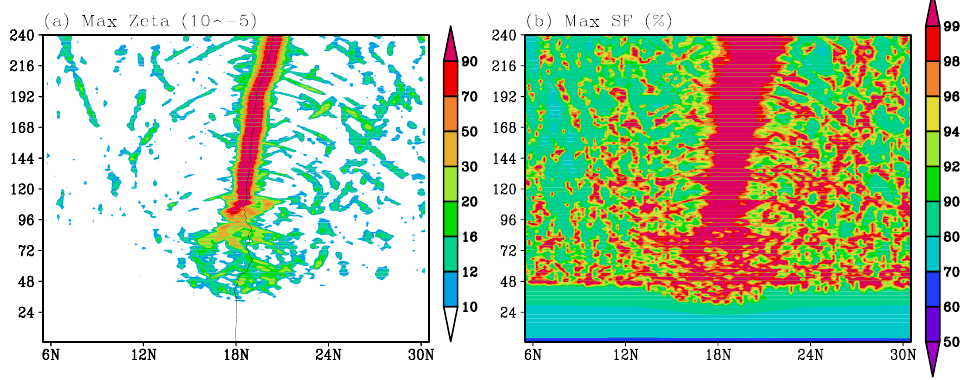
Fig. 10. “Fujita Diagram:” (a) depicts the time evolution of the maximum relative vorticity along each latitude. The x -axis indicates the latitude of the vorticity maximum and the y -axis is time (from Day 0 to Day 10); (b) depicts the time evolution of the maximum saturation fraction from surface to 500hPa. The ordinate is time (h).